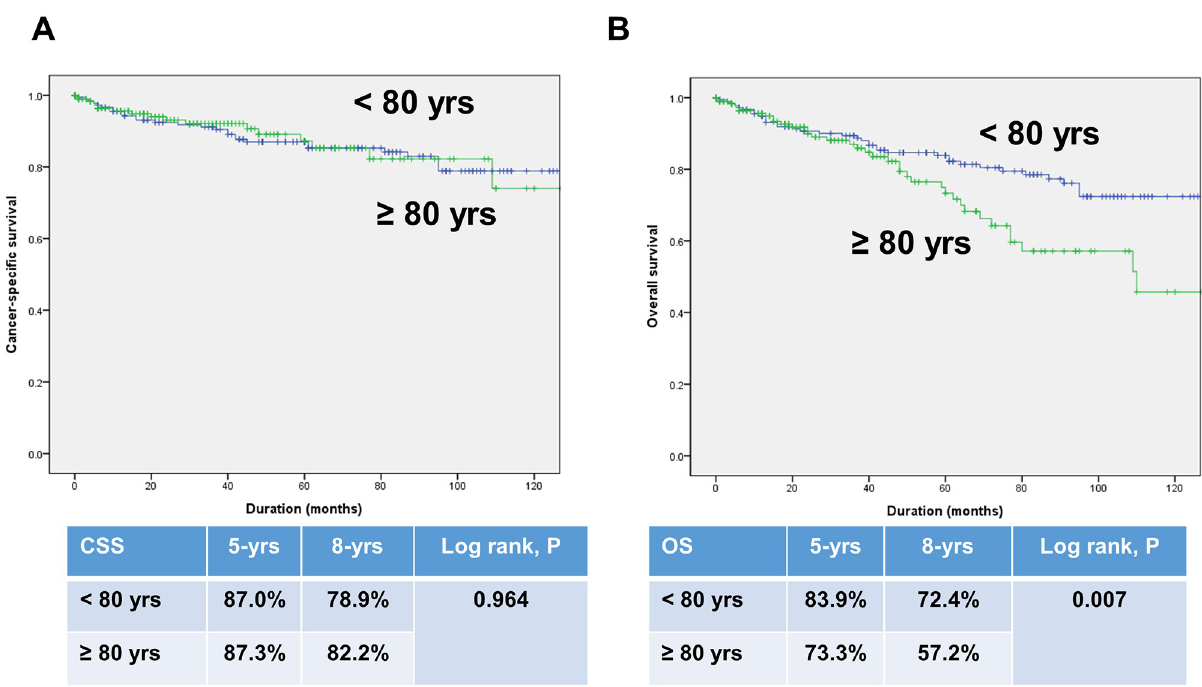
Fig 2. Kaplan-Meier curves for cancer-specific survival (A) and overall survival (B) in patients by age group (octogenarian vs. younger group) after propensity score matching.